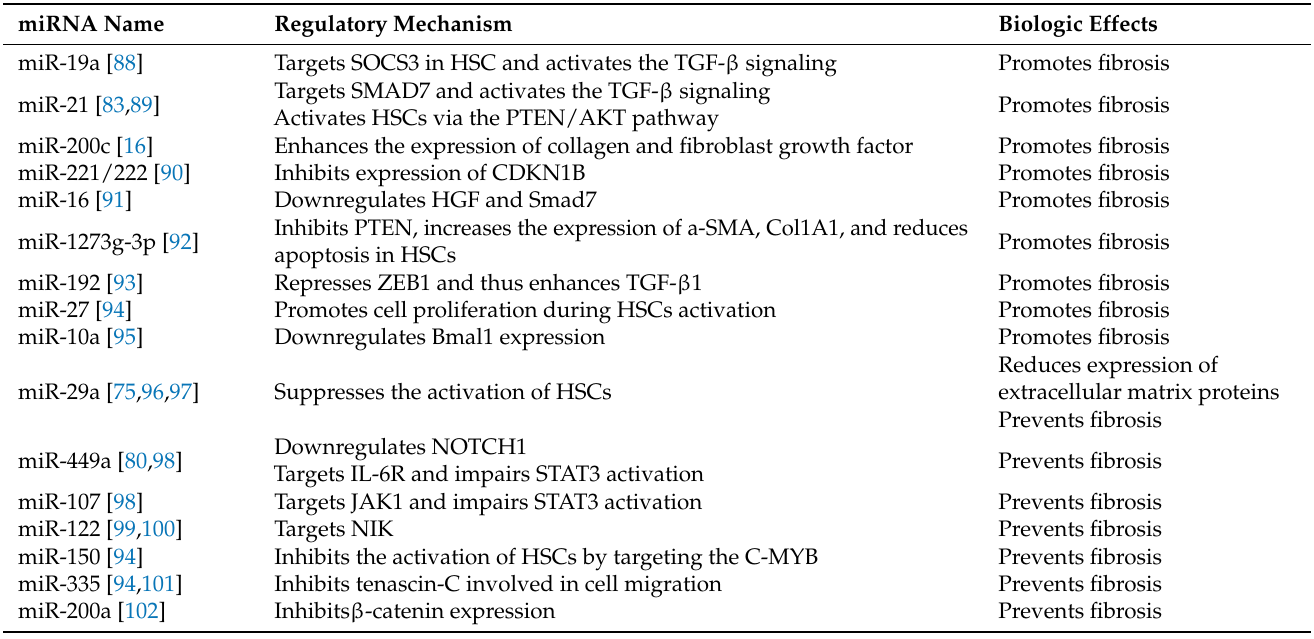
Table 4. miRNAs modulating HCV-related